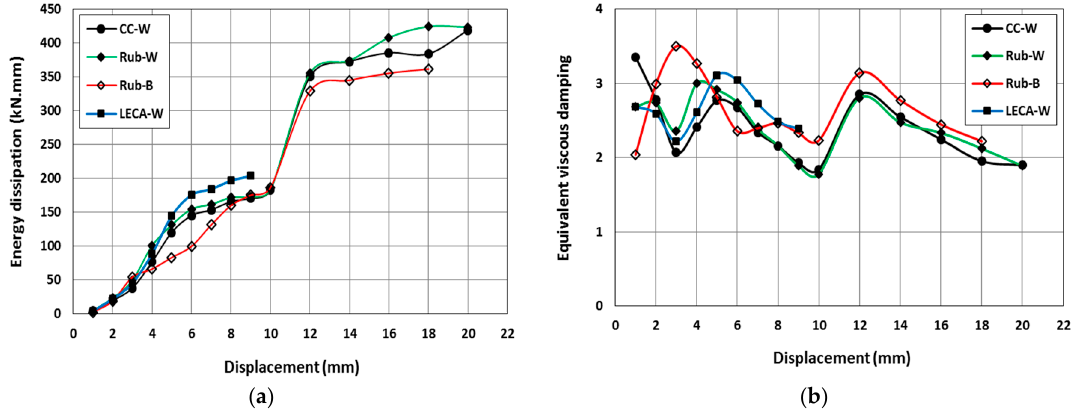
Figure 13. (a) Energy dissipation of the tested specimens, and (b) Equivalent viscous damping of the tested